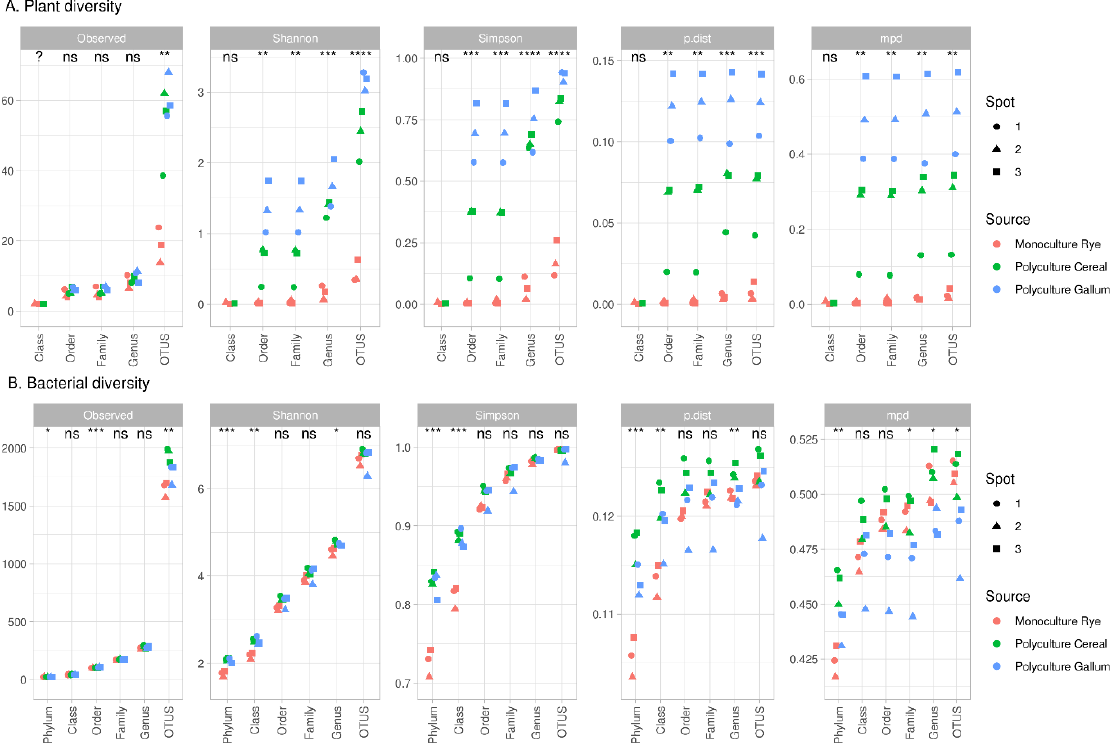
Figure 3. Alpha-diversity indices for plant and bacterial communities (significance for ANOVA in groups; ?—not available, ns—non-significant, *— p < 0.05, **— p < 0.01, ***— p < 0.005, ****— p < 0.001). ( A ): Plant diversity; ( B ): Bacterial diversity.